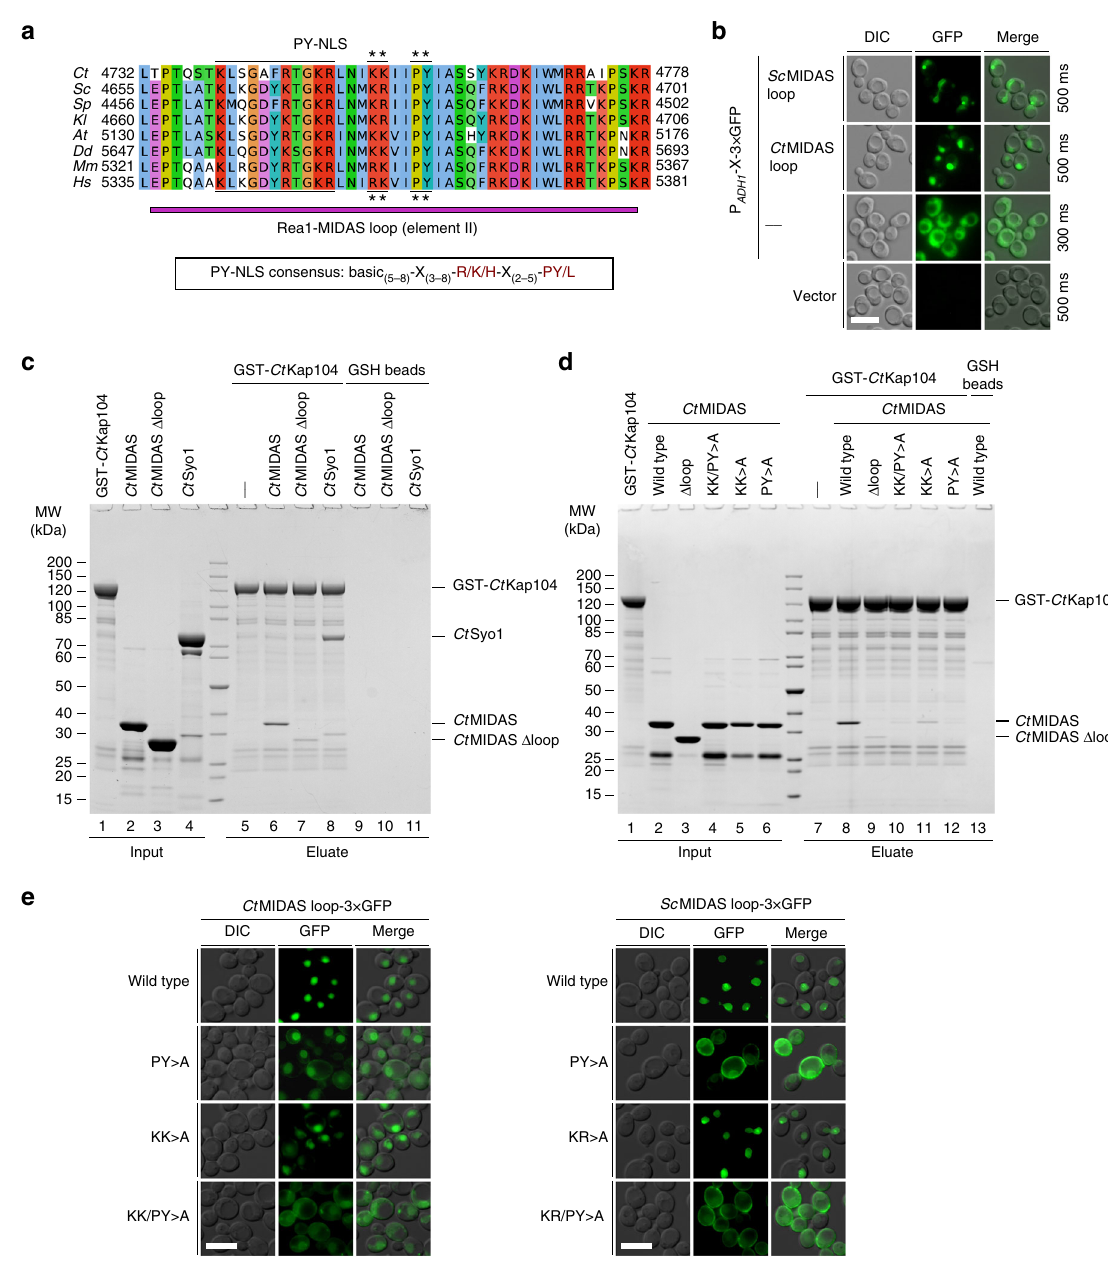
Fig. 5 The Rea1 MIDAS element II loop harbors a conserved PY-NLS that interacts with Kap104. a Multiple sequence alignment of Rea1 showing the MIDAS loop region (purple bar). The PY-NLS is highlighted and the mutated residues are marked with an asterisk. The PY-NLS consensus sequence is shown below the alignment. The sequences of Chaetomium thermophilum ( Ct ), Saccharomyces cerevisiae ( Sc ), Schizosaccharomyces pombe ( Sp ), Kluyveromyces lactis ( Kl ), Arabidopsis thaliana ( At ), Dictyostelium discoideum ( Dd ), Mus musculus ( Mm ), and Homo sapiens ( Hs ) were aligned with Clustal Omega and visualized with Jalview. b The Sc MIDAS loop (residues 4655 – 4701) or the Ct MIDAS loop (residues 4732 – 4778) were fused to a 3×GFP reporter and the subcellular localization of fusion proteins was monitored by fl uorescence microscopy. Nomarski (DIC), GFP and merged pictures are shown. Scale bar: 5 µ m. c , d Binding assay between GST- Ct Kap104 and Ct Rea1-MIDAS, Ct MIDAS Δ loop, the indicated Ct MIDAS PY-NLS point mutants, and Ct Syo1. After incubation with GSH-agarose, GST- Ct Kap104 and bound proteins were eluted with GSH and analyzed by SDS-PAGE and Coomassie staining. e The subcellular localization of the Ct MIDAS loop (left), the Sc MIDAS loop (right), or indicated PY-NLS point mutants fused to 3×GFP was monitored by fl uorescence microscopy. Nomarski (DIC), GFP and merged pictures are shown. Scale bars: 5 µ m. Source data are provided as a Source Data fi le Rea1-MIDAS loop triggers Rsa4 release from pre-60S particles . Sc MIDAS KR/PY>A (all four PY-NLS consensus residues mutated) showing the most striking cytoplasmic mislocalization Based on these fi ndings, we examined whether it is possible to (Fig. 5e). We conclude from these studies that the Rea1-MIDAS rescue the deletion of the PY-NLS from the Rea1-MIDAS loop by loop harbors a functional NLS that mediates nuclear import of inserting another PY-NLS from an unrelated nuclear protein. the Rea1 AAA + ATPase, which is a prerequisite for assembly of Hence, we considered the well-studied PY-NLSs present in the Rea1 into pre-60S particles. yeast nuclear proteins L4 (also known as uL4), Syo1, and Hrp1 NATURE COMMUNICATIONS| (2019) 10:3050